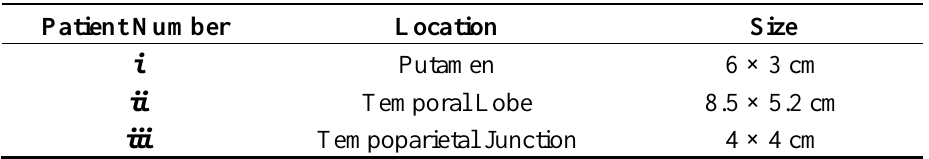
Table 2. Stroke location and